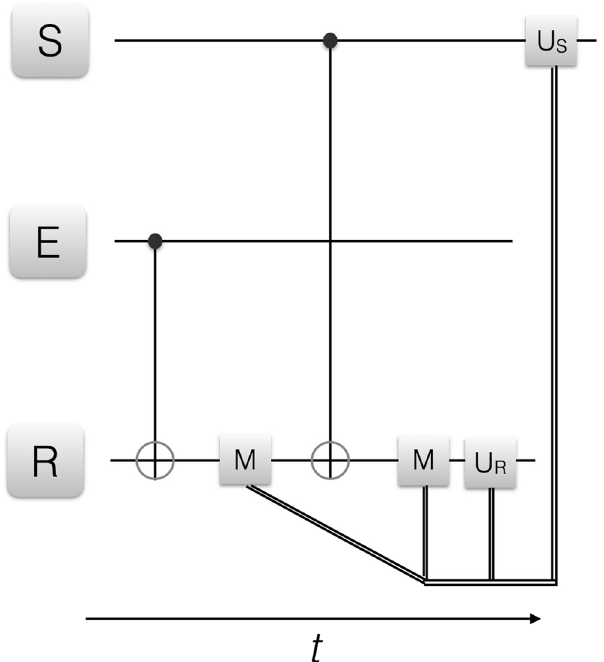
Figure 2. Quantum reinforcement learning for one qubit. We depict the circuit representation of the proposed learning protocol. S, E and R denote the agent, environment and register qubits, respectively. CNOT gates between E and R as well as between S and R are depicted with the standard notation. M is a measurement in the computational basis chosen, while U S and U R are local operations on agent and register, respectively, conditional on the measurement outcomes via classical feedback loop. The double lines denote classical information being fedforward. The protocol can be iterated upon changes in the